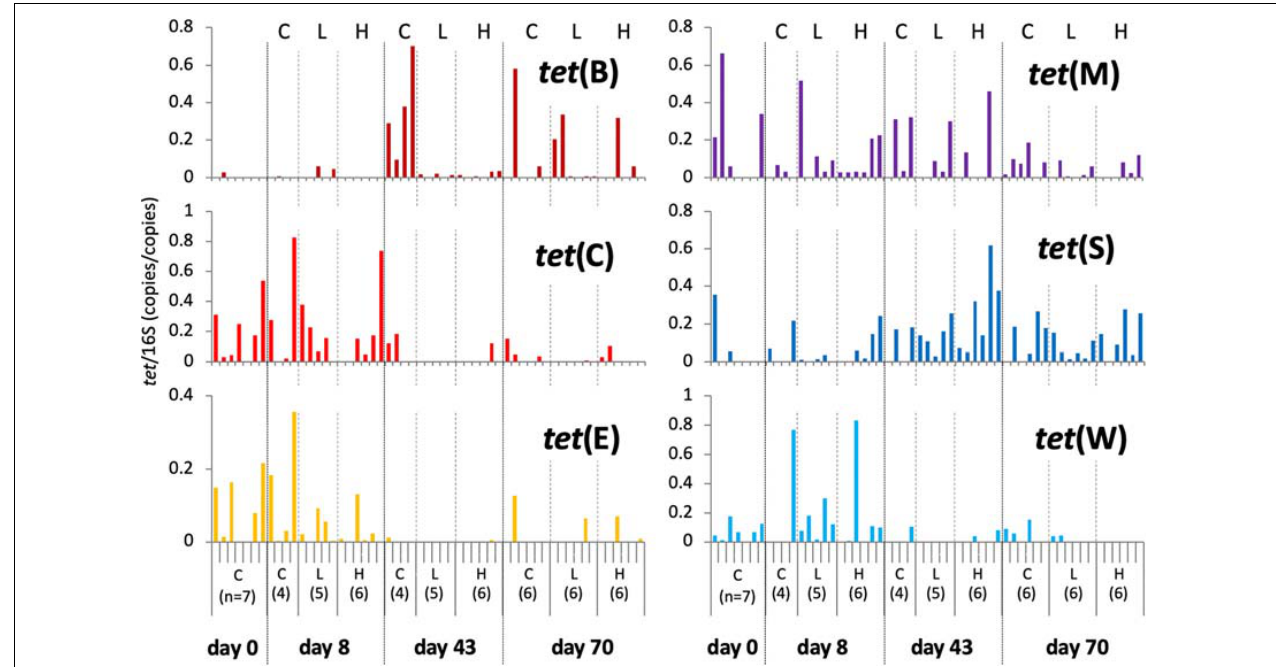
FIGURE 3 | Copy numbers of tet genes in fish intestinal content; values were normalized to those of 16S rRNA genes in the respective samples. Results for individual fish are shown separately within each group ( n = 4–7) and sampling day. C, control; L, Low-OTC; H,